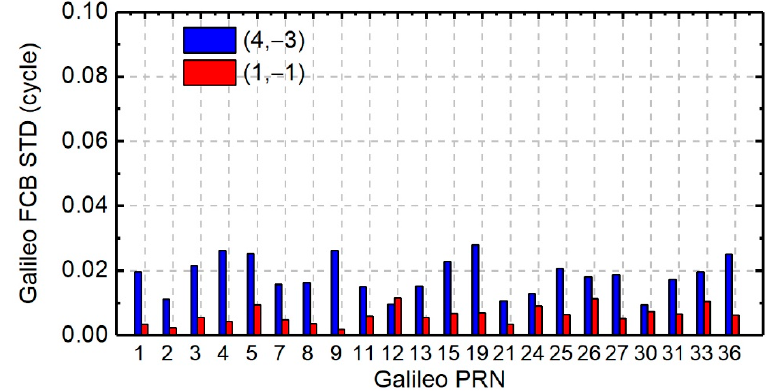
Figure 15. STD of the one day (3 September 2019) Galileo FCB time series for each satellite NL and WL combination.